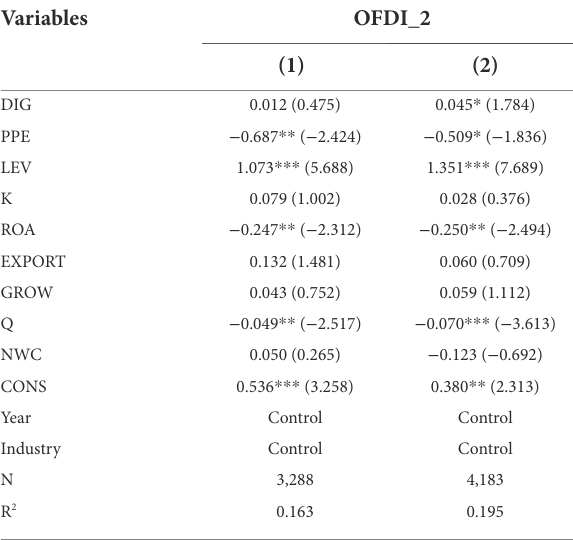
TABLE 7 Regression results according to the “G20 Summit” time